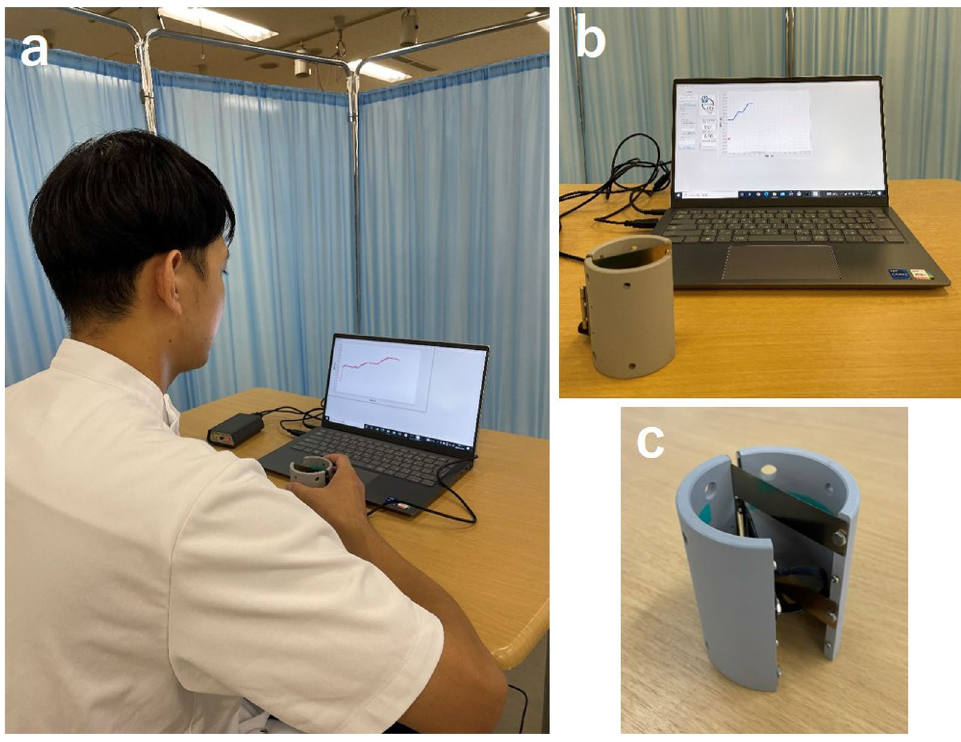
Figure 1. iWakka. ( a ) State when using iWakka, ( b ) iWakka and monitor/computer displaying feedback, ( c )